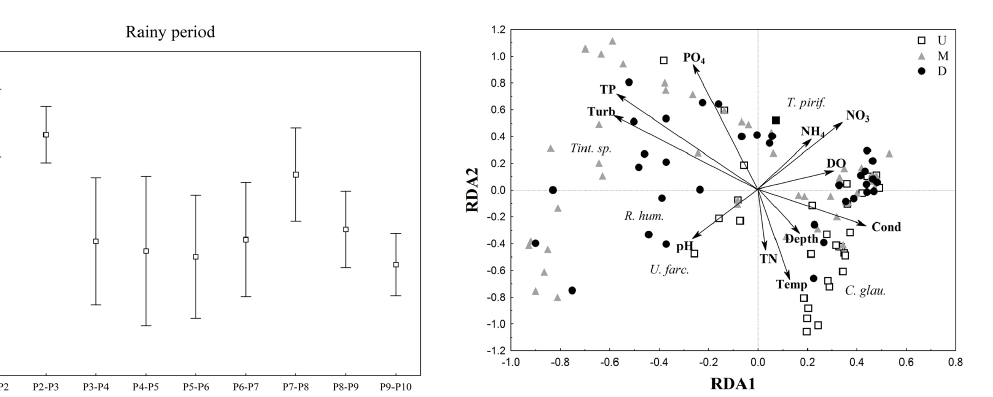
Figure 9. Ordination diagram for the two first axes of the Redundancy Analysis, according to the environmental variables and ciliate abundance along the three stretches of the Paraná River in the rainy period. Cond = conductivity; D = downstream; DO = dissolved oxygen; Depth = habitats’ depth; M = middle; NO3 = nitrate; NH4 = ammonium; PO4 = orthophosphate; Temp = temperature; TN = total nitrogen; TP = total phosphorus; Turb = turbidity; Up = upstream.